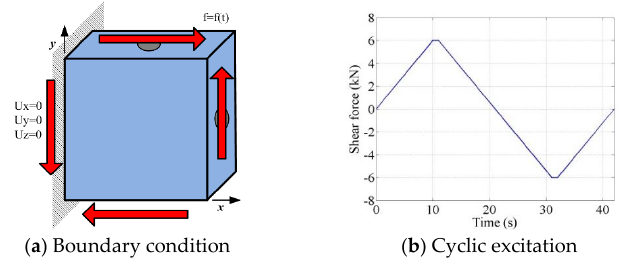
Figure 11. Local test rc.2: cyclic pure shear loading.